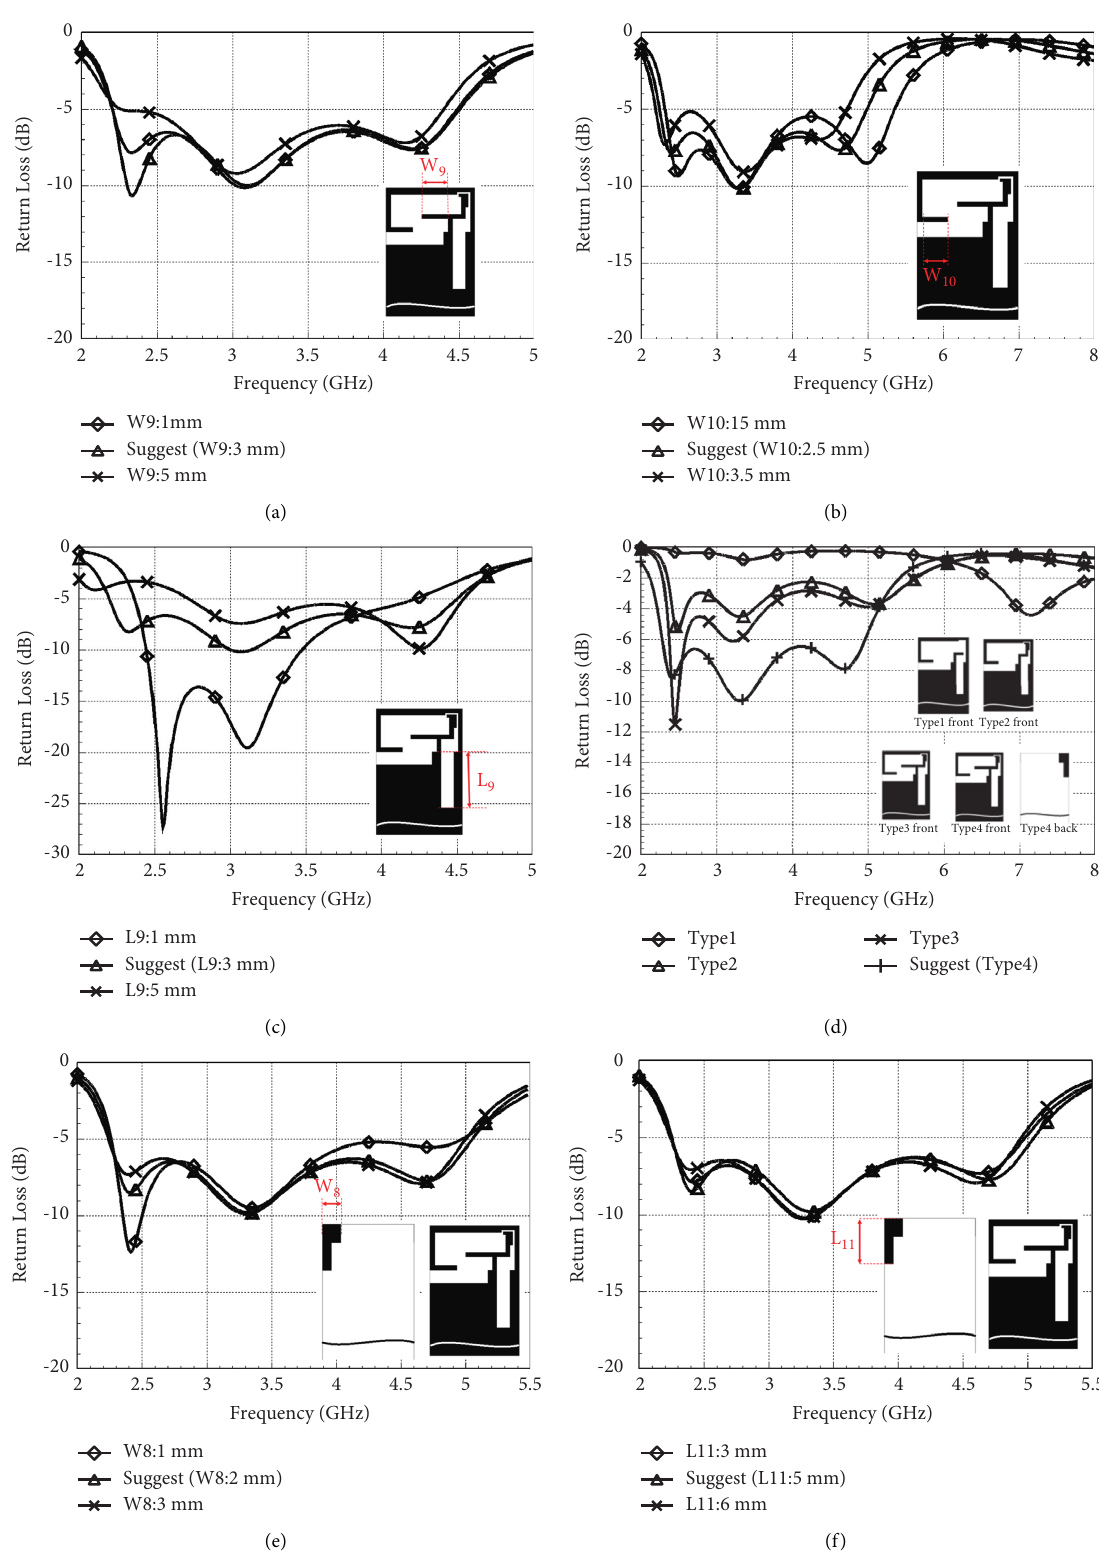
Figure 4: Study on the parameters of the reflection coefficients of the various lengths of the proposed antennas: (a) adjust parameters for W strip length; (b) adjust parameters for W 6 strip length; (c) adjust parameters for L a strip length; (d) various types with strip 2 and 3 and with/ without the back-coupled patch; (e) adjust parameters for W 8 strip width; (f) adjust parameters for L 11 strip